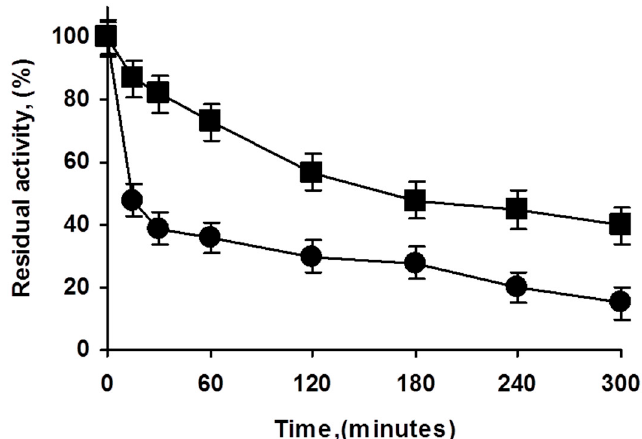
Figure 3. Effect of enzyme loading in the inactivation courses of octyl PFL biocatalysts. Inactivation carried out in 50 mM Tris at pH 7 and 75 °C. Experiments details as described in Methods. Squares: highly loaded biocatalyst; circles: lowly loaded biocatalyst.